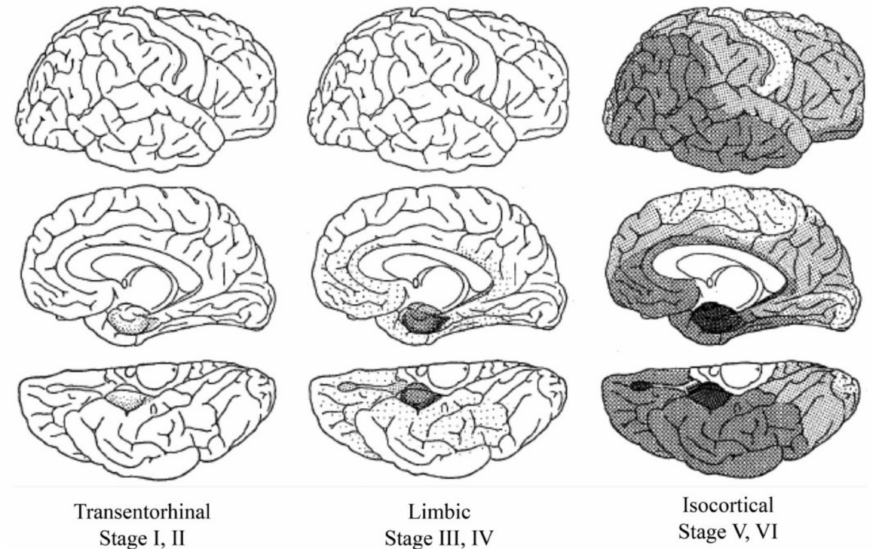
Figure 3. Schematic representation of Braak stages [39]. Note that p-tau in the isocortical stages is usually accompanied by amyloid- β deposits and neurocognitive dysfunction. Braak stages I through IV in the absence of amyloid- β has no clear association with clinical signs. Reproduced with permission from